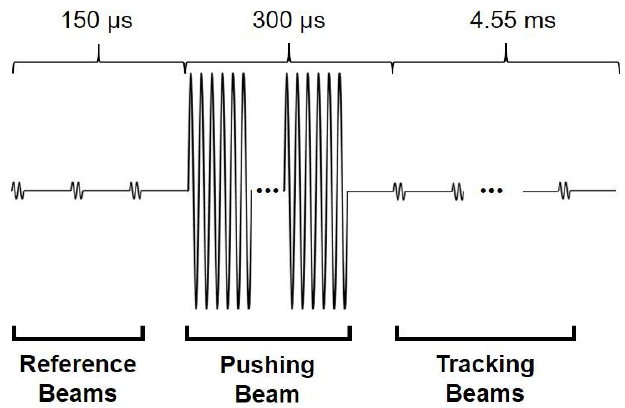
Figure 5. Schematic diagram of the input sequence composed of reference beams, pushing beam, and tracking beams used in experiment. The reference and tracking beams consist of 2-cycle sine wave, and the pushing beam consists of 500-cycle sine wave.